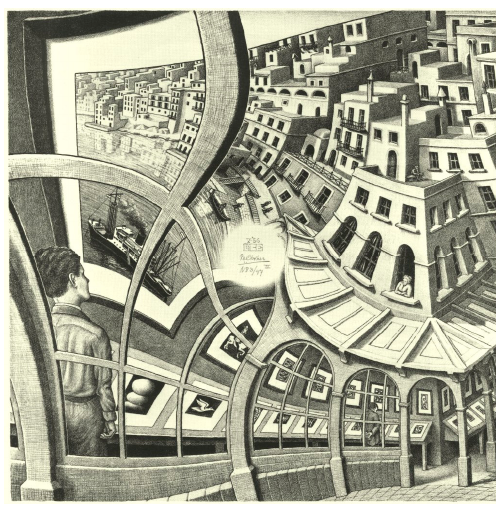
Figure 15. M. C. Escher, Print Gallery , 1956.